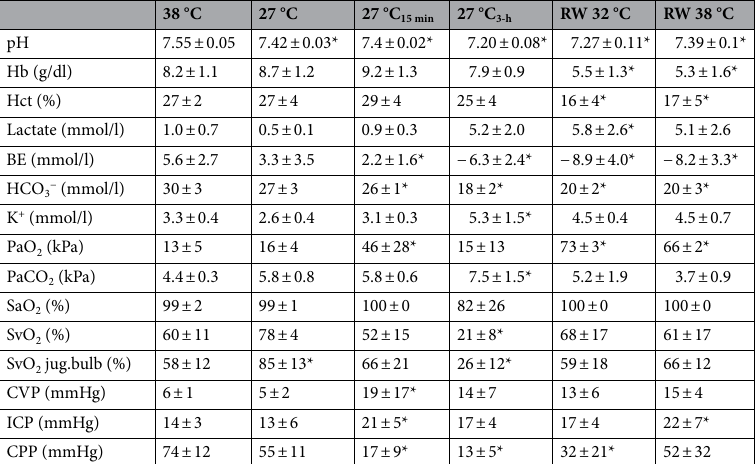
Table 1. Plasma biochemical variables, and values for cerebral pressures. Hct, haematocrit; BE, base excess; HCO 3− , bicarbonate; P a O 2 , arterial partial O 2 pressure; P a CO 2 , venous partial O 2 pressure; Sat a O 2 , arterial O 2 saturation; Sat v O 2 , venous O 2 saturation; CVP, central venous pressure; ICP, intra-cerebral pressure; CPP, cerebral perfusion pressure (CPP = MAP − ICP). n = 8, values are mean and SD. * p < 0.05 statistically significantly different from baseline value.